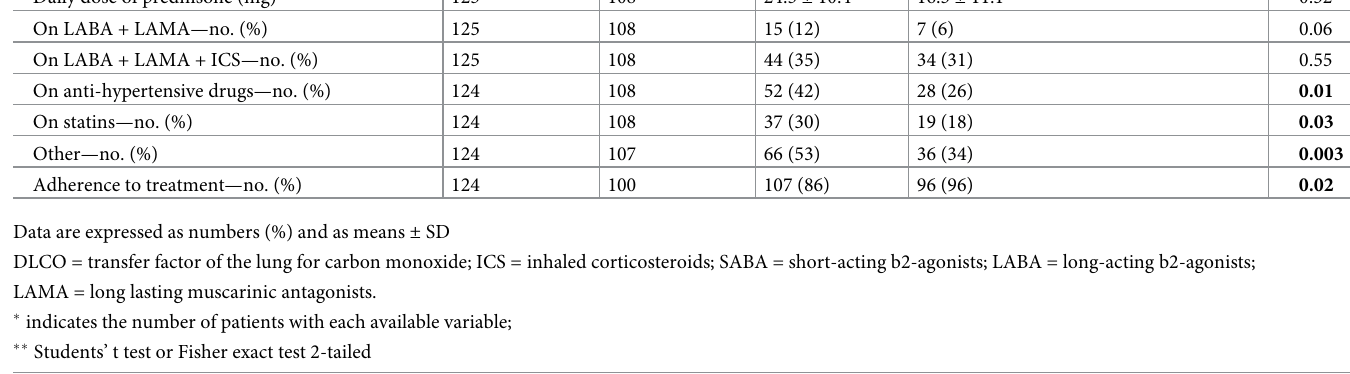
Finally, the proportion of COPD patients necessitating anti-hypertensive drugs (p = 0.01), statins (p = 0.03), or other therapies (p = 0.003) was lower in Cluster 2 than in Cluster 1 (Table 2). No difference was observed between the two clusters in terms of gender, age, ethnic origin, GOLD stages, smoking history, biology (including serum levels of CRP), respiratory function, symptoms and treatements (Table 2). Failure to observe differences in these parame- ters may be linked, at least in part, to the higher proportion of COPD patients belonging to GOLD I and II stages in each cluster. For example, when considering the distribution of values of pre-bronchodilator FEV across COPD severity, 56% and 61% patients belonged to GOLD I 1 and II in Cluster 1 and 2, respectively (S1